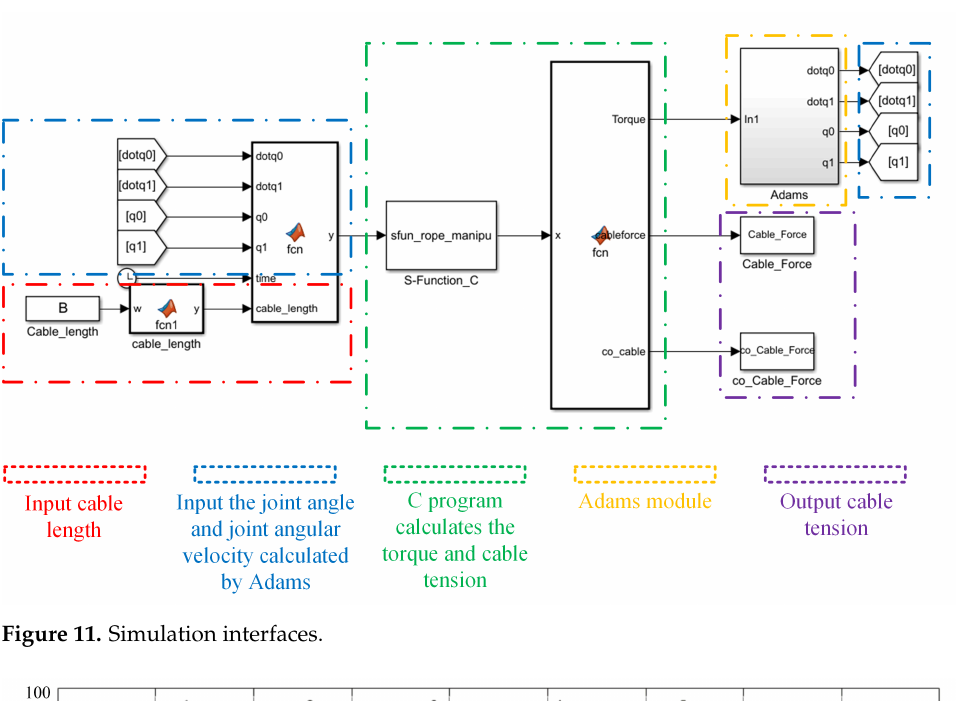
Figure 10. Dynamic simulation flowchart.